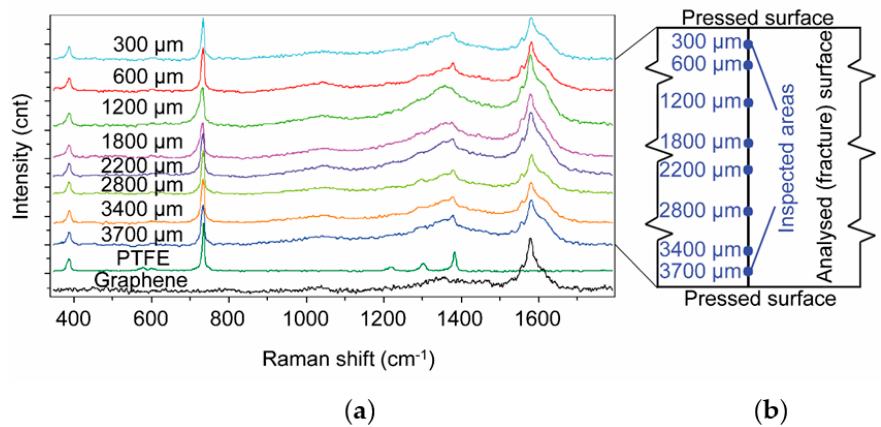
Figure 1. ( a ): Raman spectra of PTFE / graphene-4 sample in di ff erent depth on the cryo-fractured surface; ( b ): the investigated locations in PTFE / graphene-4. (The reference spectra of the neat graphene and PTFE are introduced at the bottom of the diagram).